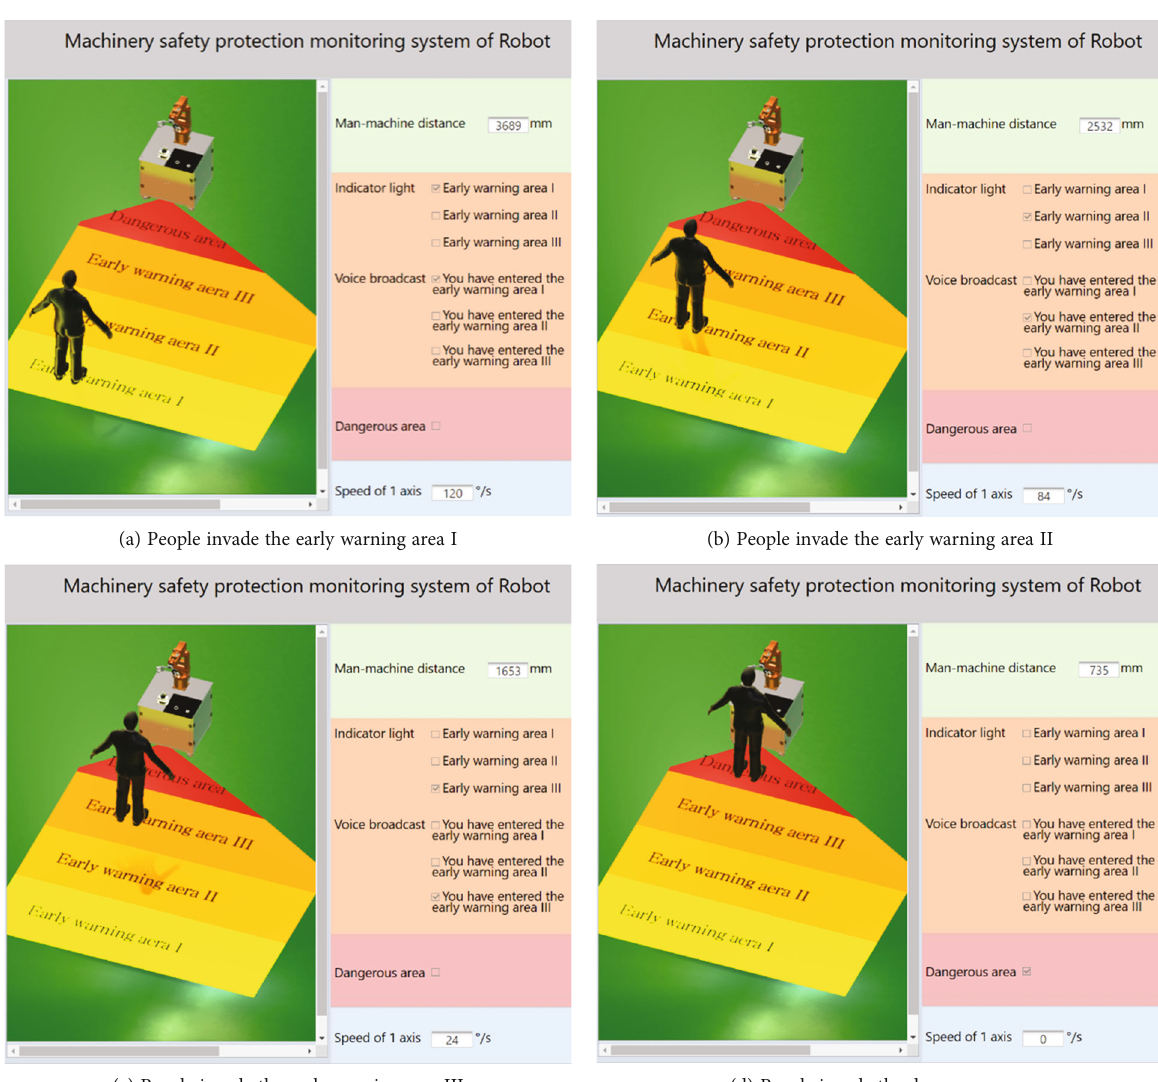
Figure 11: Real-time status of monitoring